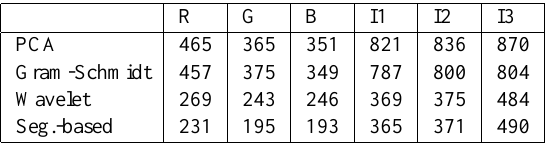
Table 1: Root mean square error of different fusion methods com- pared to the upsampled original hyperspectral image (reflectivity values, range 0-10000) The wavelengths of the represented bands are 0.635 µ m (R), 0.544